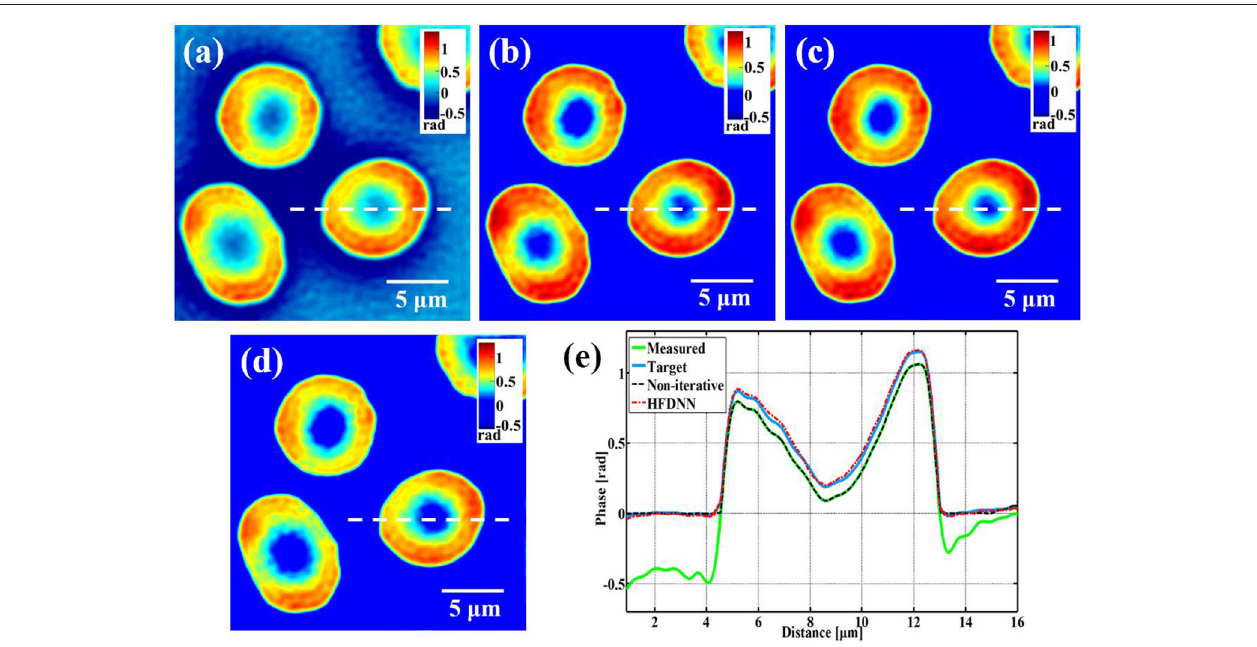
FIGURE 5 | The reconstructed results of living red blood cells. (a) The measured image; (b) the target data; (c) the reconstructed image by the HFDNN; (d) the reconstructed image by the non-iteratitave method; (e) the phase profiles along the same position of the same cell drawn in (a–d) ; the green curve illustrates the profile of the measured data; the blue curve illustrates the profile of the target data; the red dash curve illustrates the profile of the HFDNN output data; the black dash curve illustrates the profile of the non-interative reconstruction.